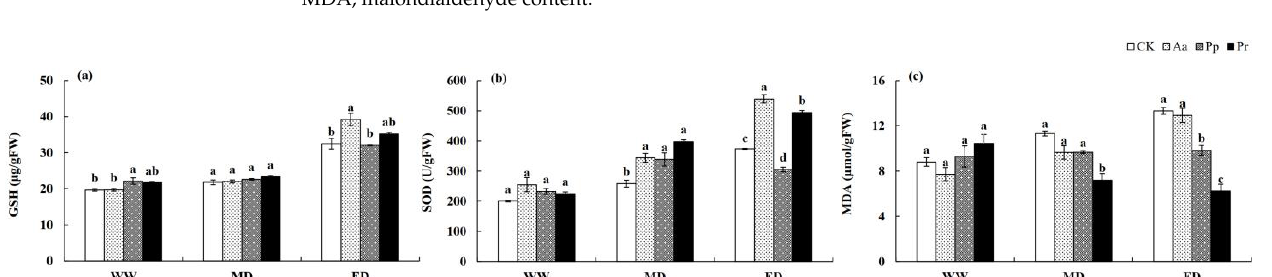
( b ) ( c ) Figure 5. The influences of the DSE treatment on the performance of wheat under three levels of water treatment based on principal component analysis. a,b,c represent principal component anal- ysis of the DSE ’s influence on the fitness of wheat seedlings under WW ( a ), MD ( b ), and ED ( c ), respectively. Leaf, leaf number. Height, plant height. GSH, glutathione content. SOD, superoxide dismutase. MDA, malondialdehyde content. SS, soluble sugar content. SP, content of soluble pro- tein. Pro, proline contents. Gs , stomatal conductance. Pn , photosynthetic rate. Ci , intercellular CO 2 concentration. Tr , transpiration rate. SDW, shoot biomass. RDW, root biomass. TDW, total biomass. ○ , ◇ ,  , and △ indicate CK, Aa, Pp, and Pr , respectively. 3.6. Influences of DSE on Leaf Photosynthetic Indexes and Chlorophyll Content DSE and water treatment significantly affected the photosynthesis indexes and chlo- rophyll content in the wheat leaves (Table 3). Under WW treatment, the Pn of wheat plants inoculated with Pr increased significantly, while the photosynthetic rate in response to inoculation with the other strains did not show an obvious increase (Figure 6a). The effect